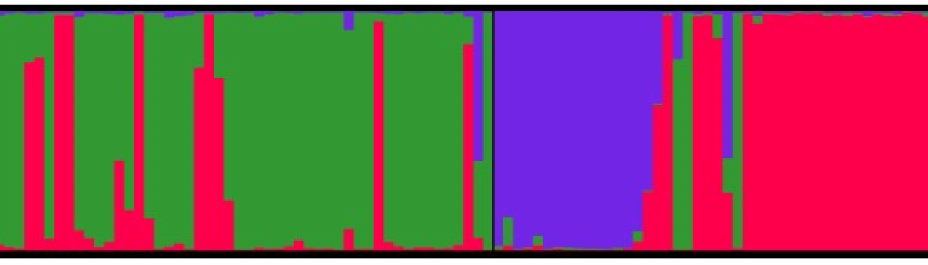
Figure 3. Population structure of K = 3 inferred by Bayesian clustering approaches based on 22 microsatellites